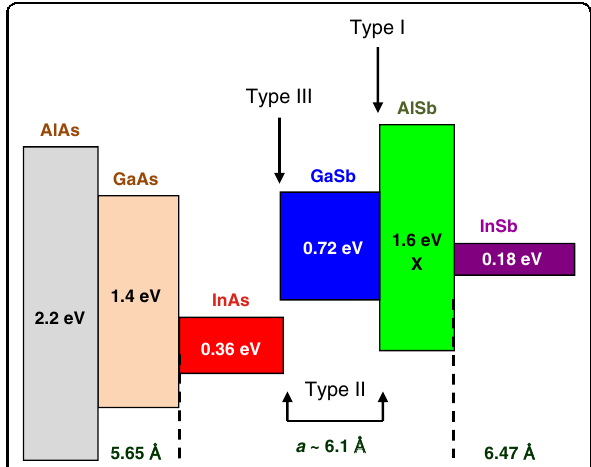
Fig. 1 Band alignment at III-As and III-Sb interfaces. The boxes represent, to scale, the bandgap of the compounds, whereas the top and bottom lines indicate the position of the conduction- and valence-band, respectively. The lattice parameters of GaAs, GaSb and InSb are indicated on the horizontal axis. The arrows show examples of band